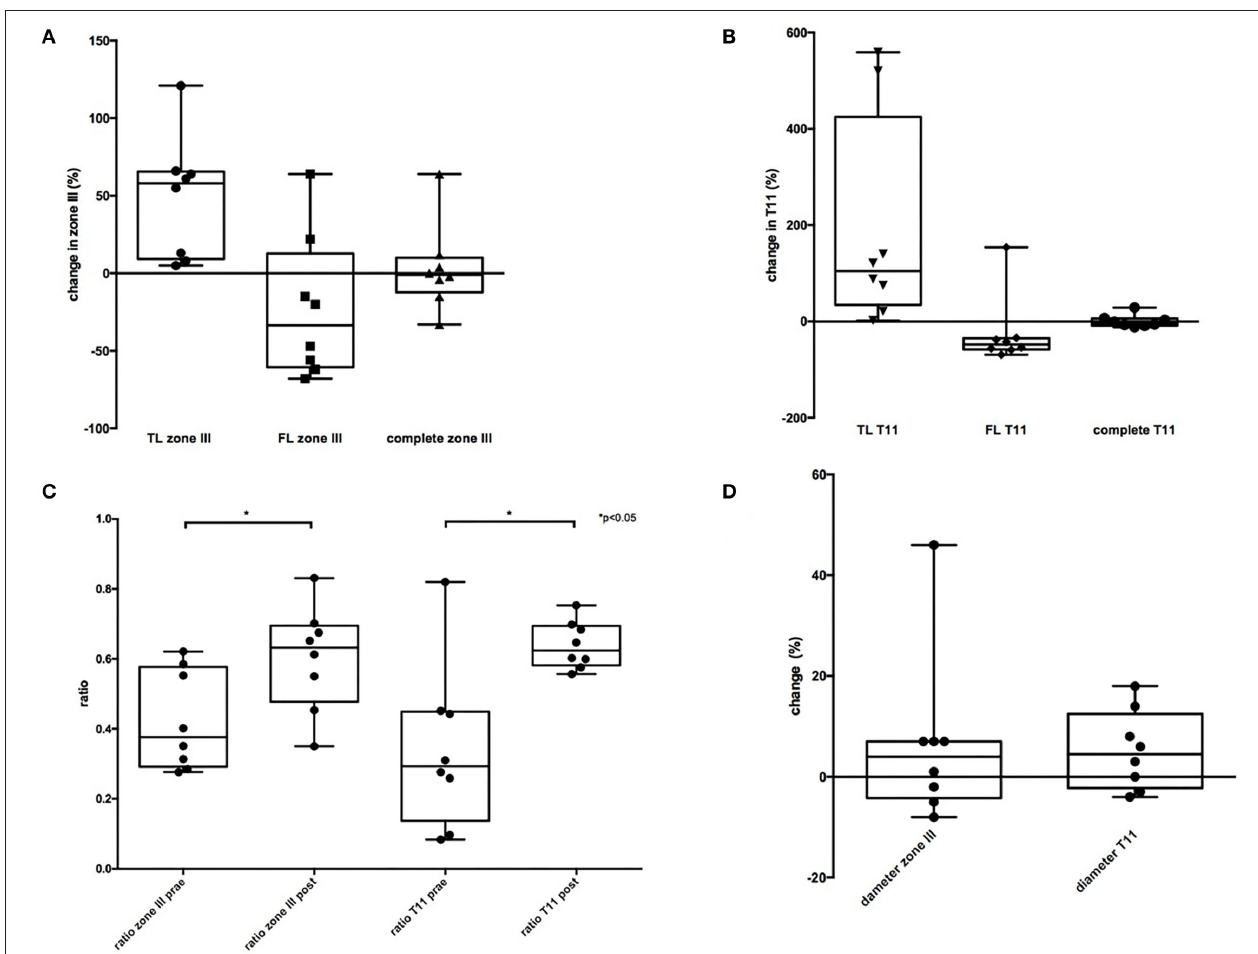
FIGURE 2 | Comparison of CT-measurement. (A) Showing an enlargement of the true lumen (TL) and a decrease of the false lumen (FL) in zone III. Area of TL + FL did not changed. (B) TL showed a significantly bigger increase in T11 and a significant decrease of the FL. Area of TL + FL did not changed. (C) ratio of TL/TL + FL was postoperatively significant higher in both zones compared to preoperative CT. (D) total diameter showed no significant difference.